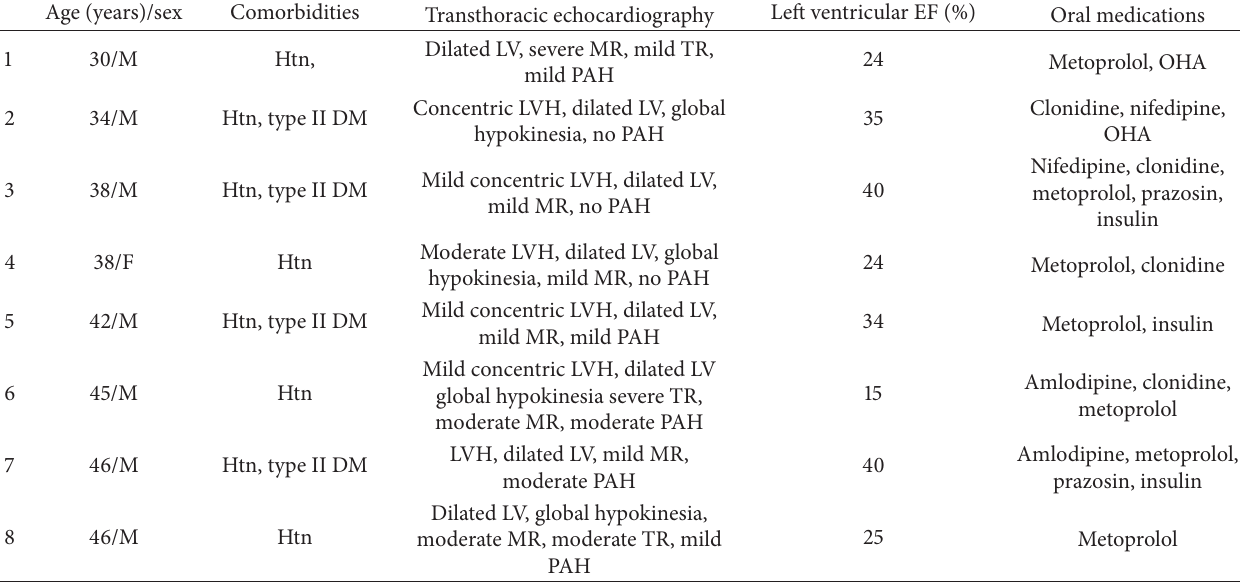
Table 1: Important patient